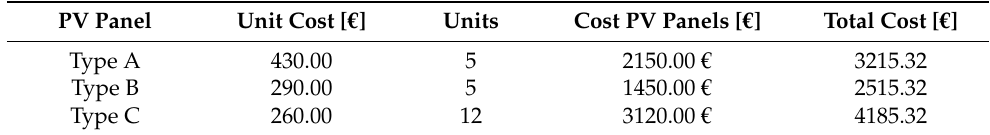
Table 4. Investment required for each PV panel model.